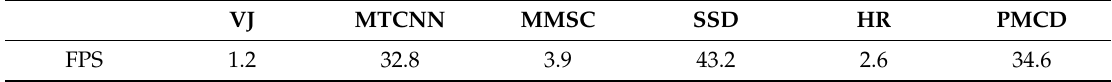
Table 3. Detection speed of di ff erent